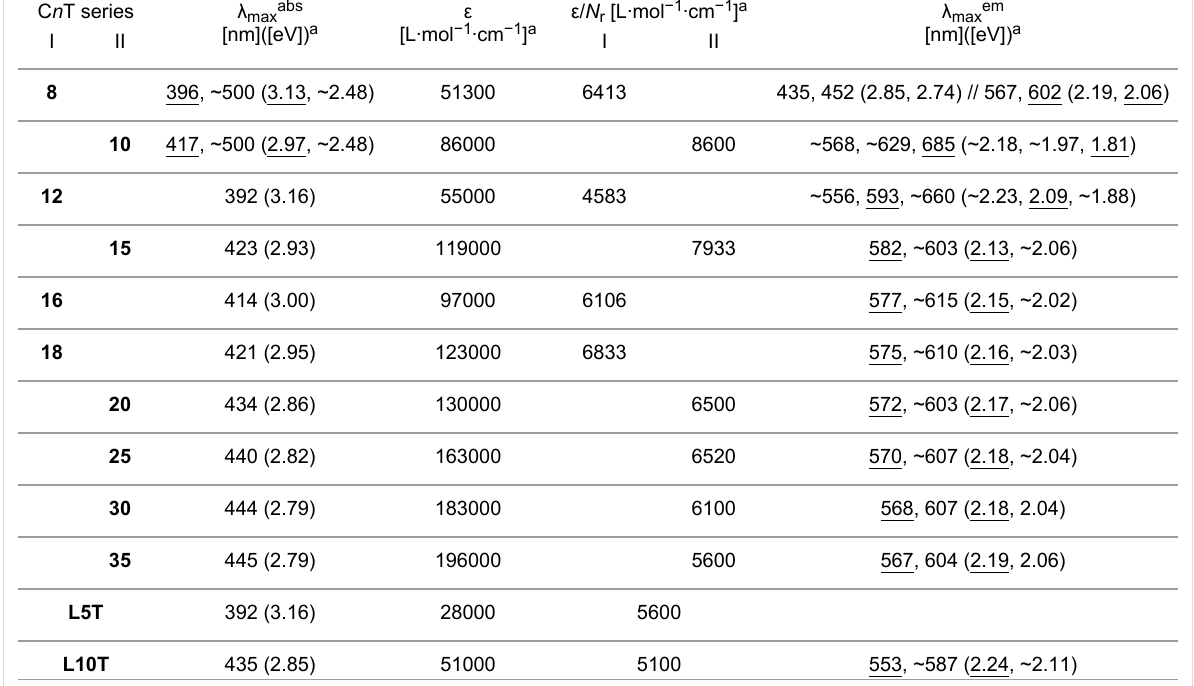
Table 1: Photophysical data of the cyclothiophenes belonging to series I and II in comparison to the linear reference compounds. Maxima at the absorption and emission wavelengths, λ maxabs and λ maxem (absolute maximum underlined), the extinction coefficient ε and the normalized extinction coefficient ( ε / N r ). L5T and L10T denote the linear homologues. Data of series II were taken from [28].